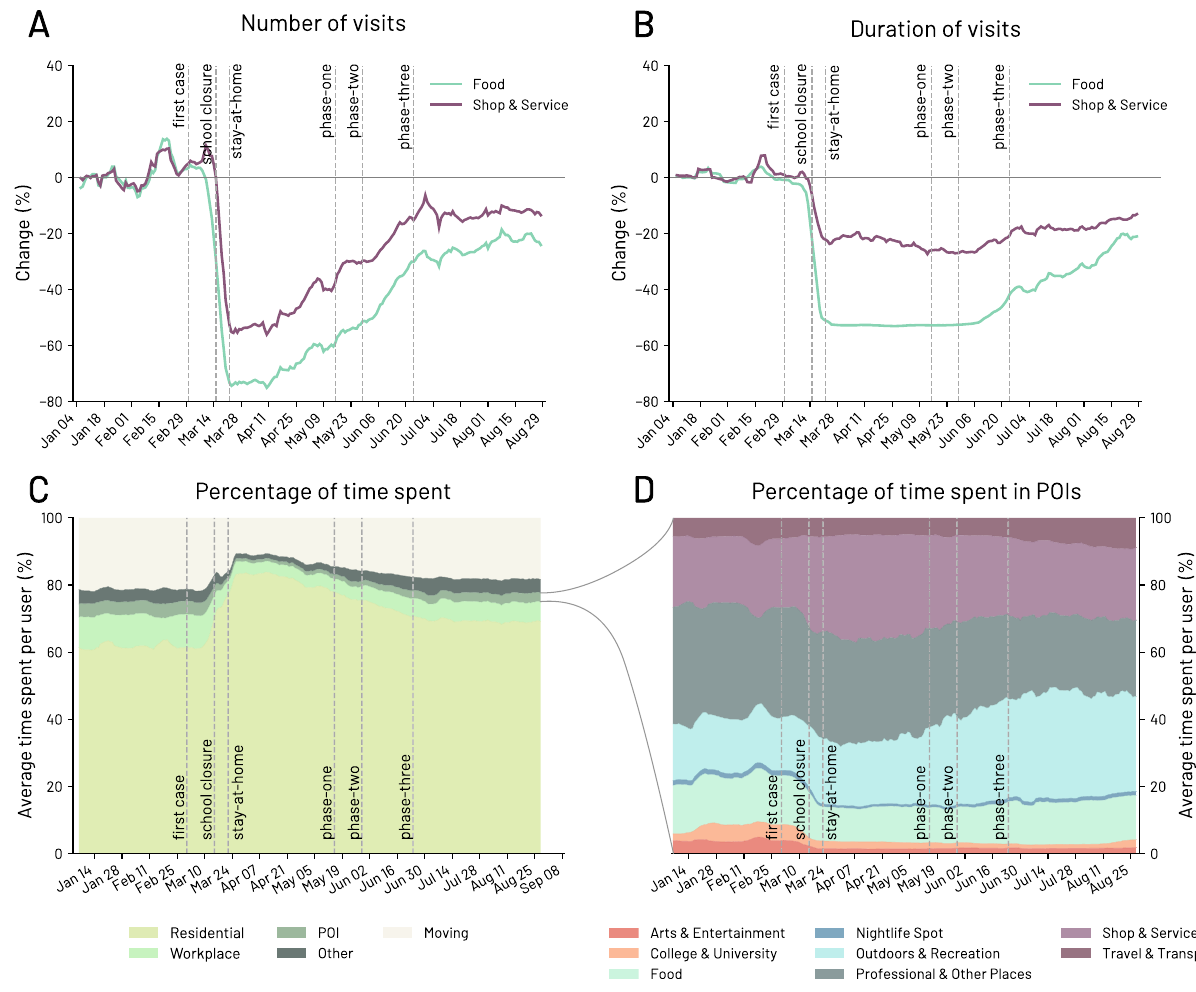
Figure 3. Changes in number and duration of visits to POIs in the state of New York. ( A ) Percentage change over time in the number of visits with respect to the baseline period (3 January 2020–28 February 2020) for venues in the Food and Shop & Service categories. ( B ) Change in percentage of the duration of visits over time with respect to the baseline period of the median duration of visits to Food and Shop & Service POIs. For visualization purposes, the original curves are smoothed using a rolling average of seven days. Vertical dashed lines indicate the date of restrictions and orders imposed by the state of New York government. ( C ) Percentage of time spent by people at Residential , Work , POIs , Other , and Moving (i.e. people in movement). ( D ) Percentage of time spent by people in venues under the eight first-level categories of